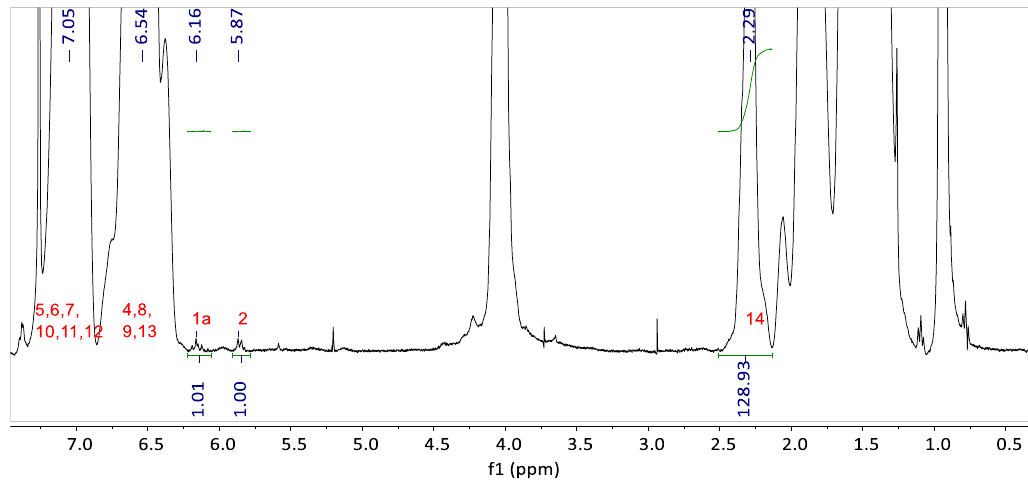
Figure 4. The 1 H NMR of G-B GA (55-4.7).